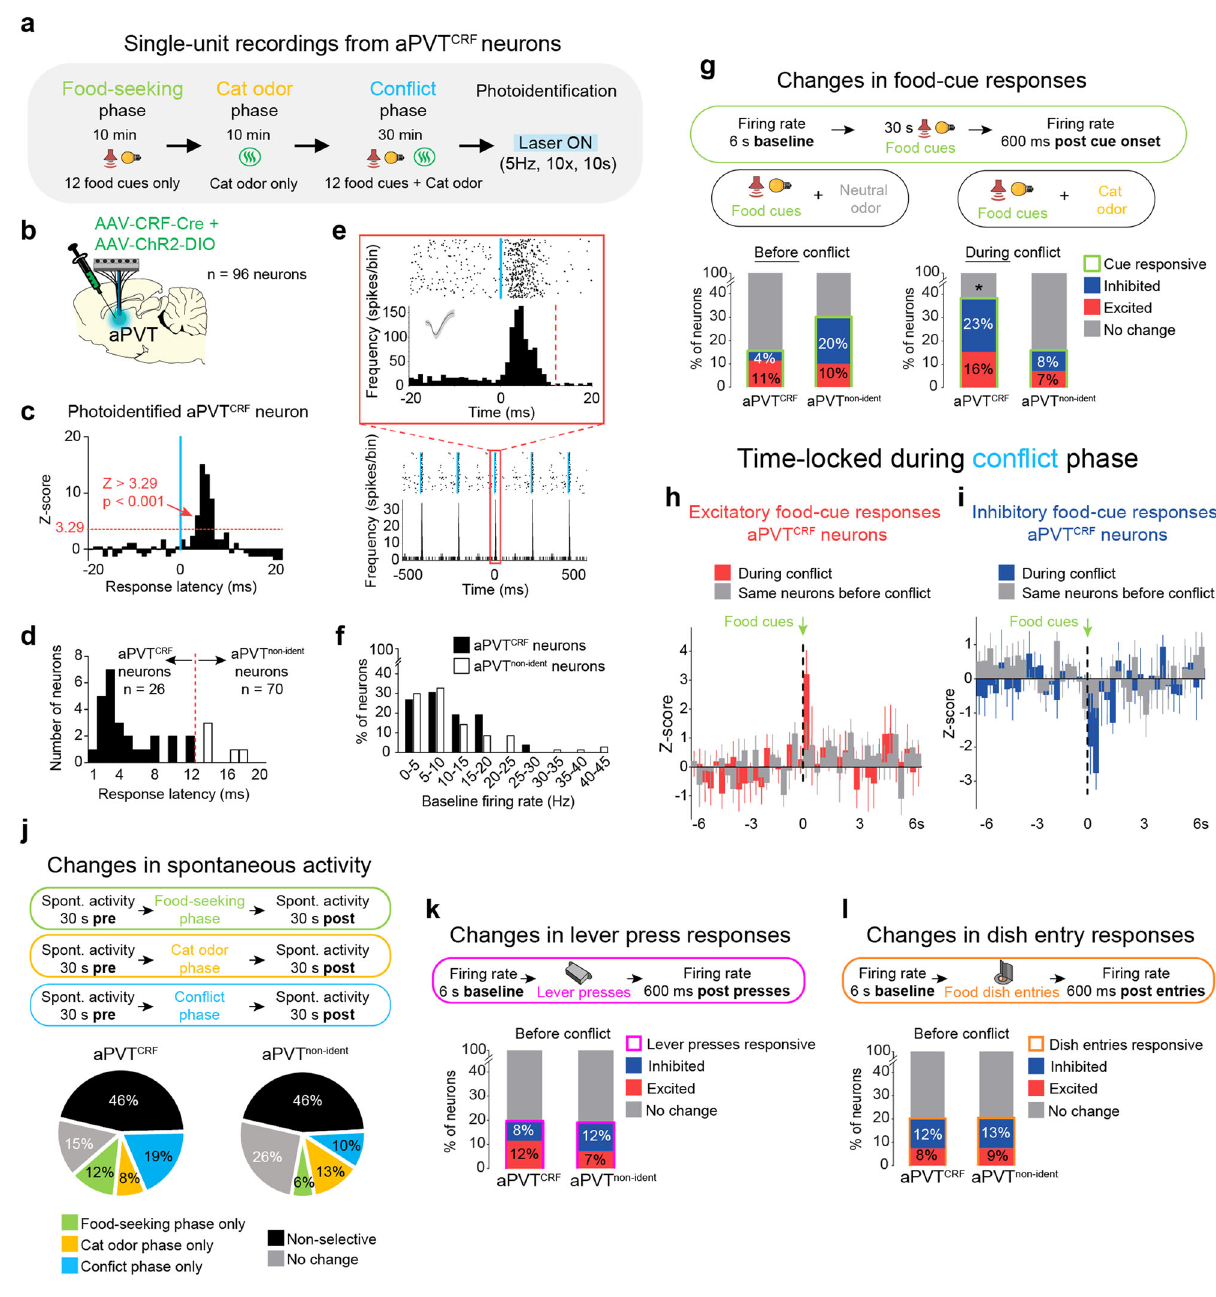
fi rst food-cue presentation, when compared to eYFP